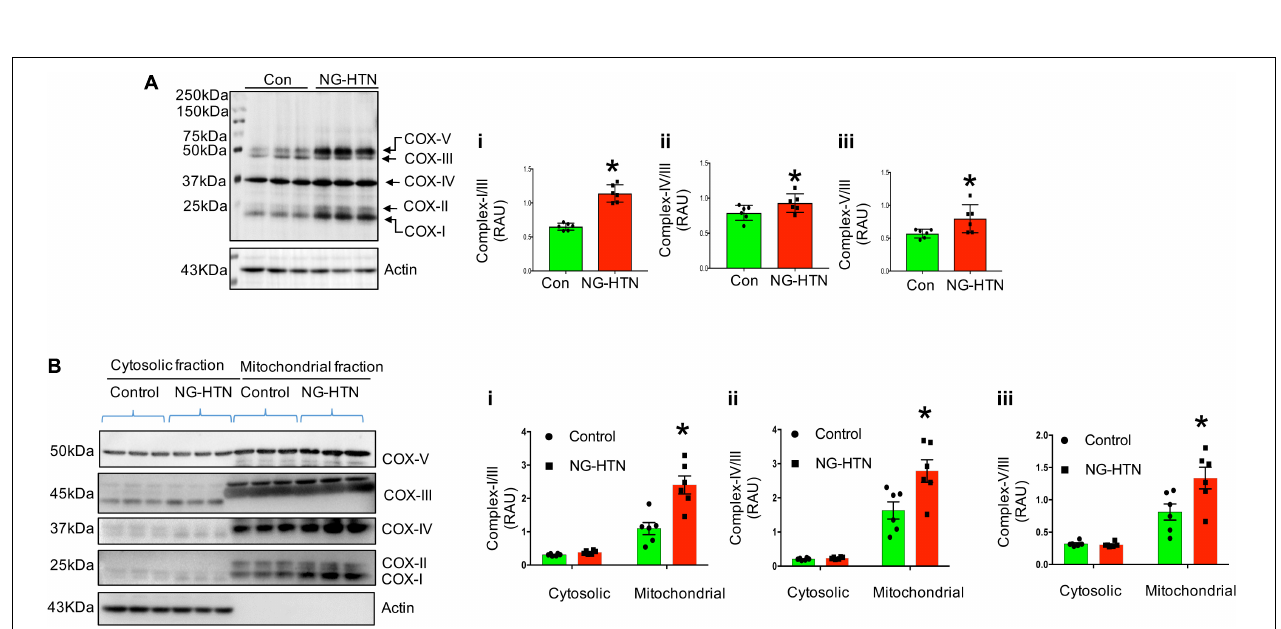
FIGURE 6 | Neurogenic hypertension and cardiac mitochondrial defective OXPHOS subunit assembly/import. (A) Left, Western blot showed mitochondrial OXPHOS complex protein level in control and NG-HTN whole hearts lysate (total OXPHOS WB antibody cocktail, cat# ab110413, Abcam). Right, (i–iii) WB quantification of mitochondrial Complex-I/III, Complex-IV/III, and Complex-V/III ratio, respectively. (B) Left, Western blots showed mitochondrial OXPHOS complex protein level in cytosol vs. mitochondria fraction in control and NG-HTN hearts. Right, (i–iii) Western blot quantification of mitochondrial Complex-I/III, Complex-IV/III, and Complex-V/III ratio, respectively. Values are mean ± SEM, dot represents n = 6 rats, * P < 0.05 vs. Control, (A) , Student’s t -test, (B) ; two-way ANOVA with Tukey’s multiple comparison test.